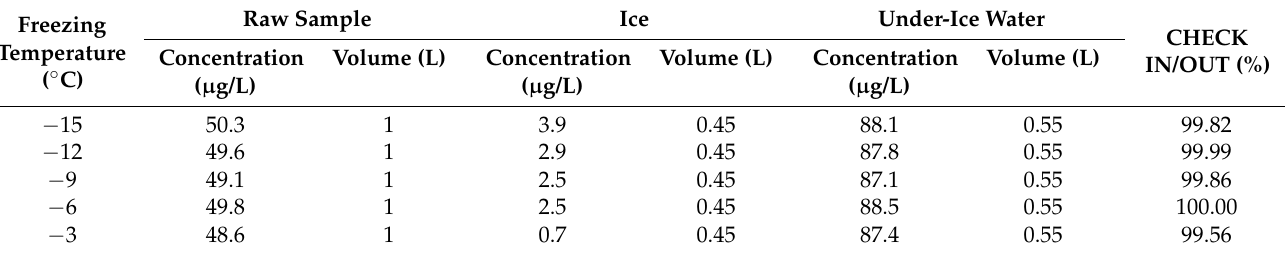
Table A3. Mass conservation verification of the freezing